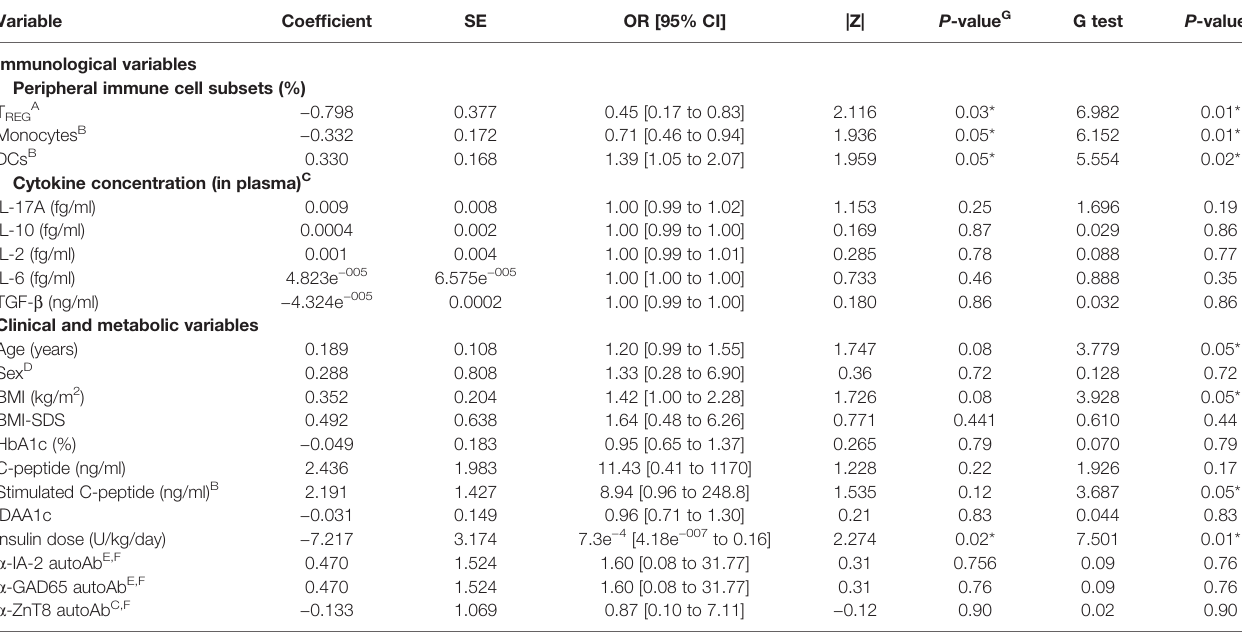
TABLE 3 | Simple logistic regressions for determinants of PR at T1D onset.